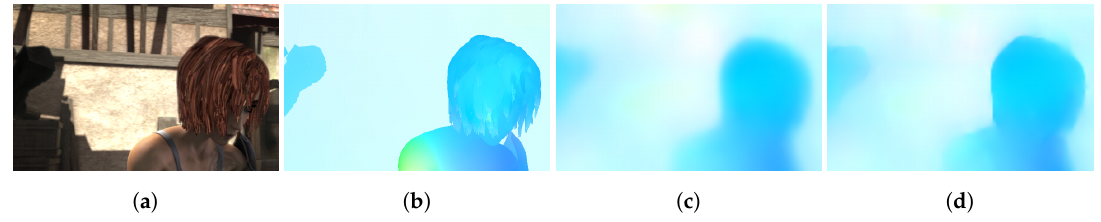
Figure 1. Illustration of global smoothing deficiency. ( a ) Reference image. ( b ) Ground truth optical flow. ( c ) Flow from a globally regularized network. ( d ) Flow from a locally regularized network. Notice that the silhouette in panel ( d ) is visibly less blurry than in panel ( c